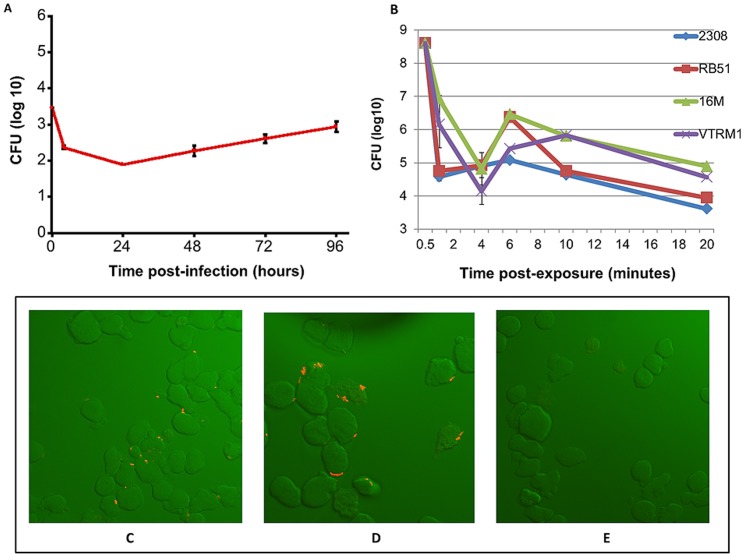
Growth of Brucella in Mono Mac 6 cells and attachment of Brucella melitensis to Mono Mac 6 cells.

Figure 1

A shows the survival of B. melitensis 16 M in Mono Mac 6 cells over 96 hours at 37°C.
Figure 1

B depicts the internalization of rough and smooth B. melitensis and B. abortus strains into Mono Mac 6 cells at 37°C for up to 20 minutes. B. abortus strains appear to enter Mono Mac 6 cells slightly faster (within about 1 minute) than B. melitensis strains (within about 4 minutes) as indicated by the lowest CFU numbers which represent the time when all bacteria have become intracellular (extracellular bacteria have been killed by gentamicin and intracellular bacteria are not multiplying yet). The confocal images in
Figures 1

C and D show the adherence of RFP-expressing B. melitensis to Mono Mac 6 cells at 1 minute (C) and 2 minutes (D) upon exposure at 4°C. Mono Mac 6 cells not exposed to Brucella are shown in
Figure 1

E.